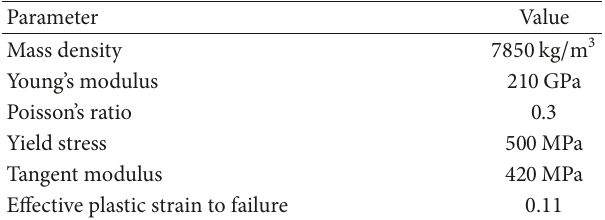
Table 3: Parameters for Piecewise Linear Plasticity material model for steel